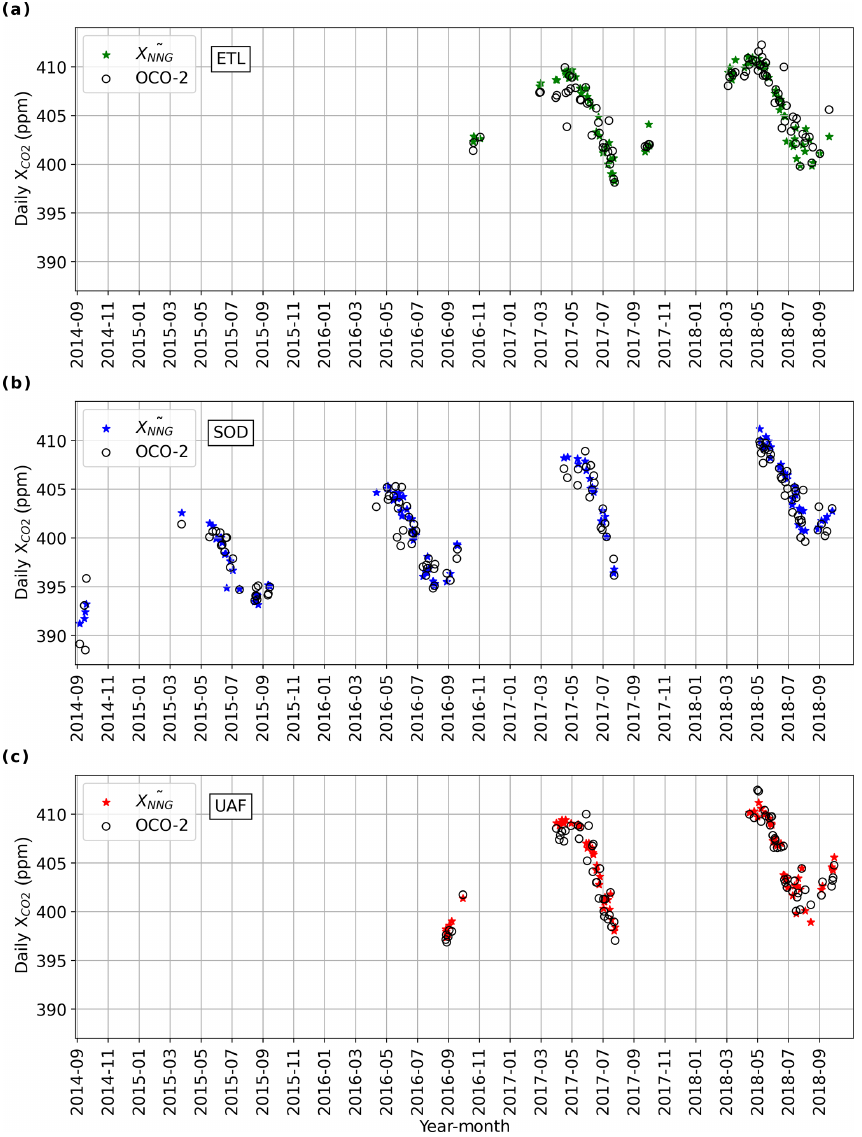
Figure 8. Time series of ground-based and satellite-based data at each boreal forest site. These consist of daily averages of OCO-2 coincident soundings filtered with boreal QC alongside corresponding daily averages of NNG with averaging kernel corrections to OCO-2 applied, as described in Sect. 3.3.1 ( ˜ X NNG